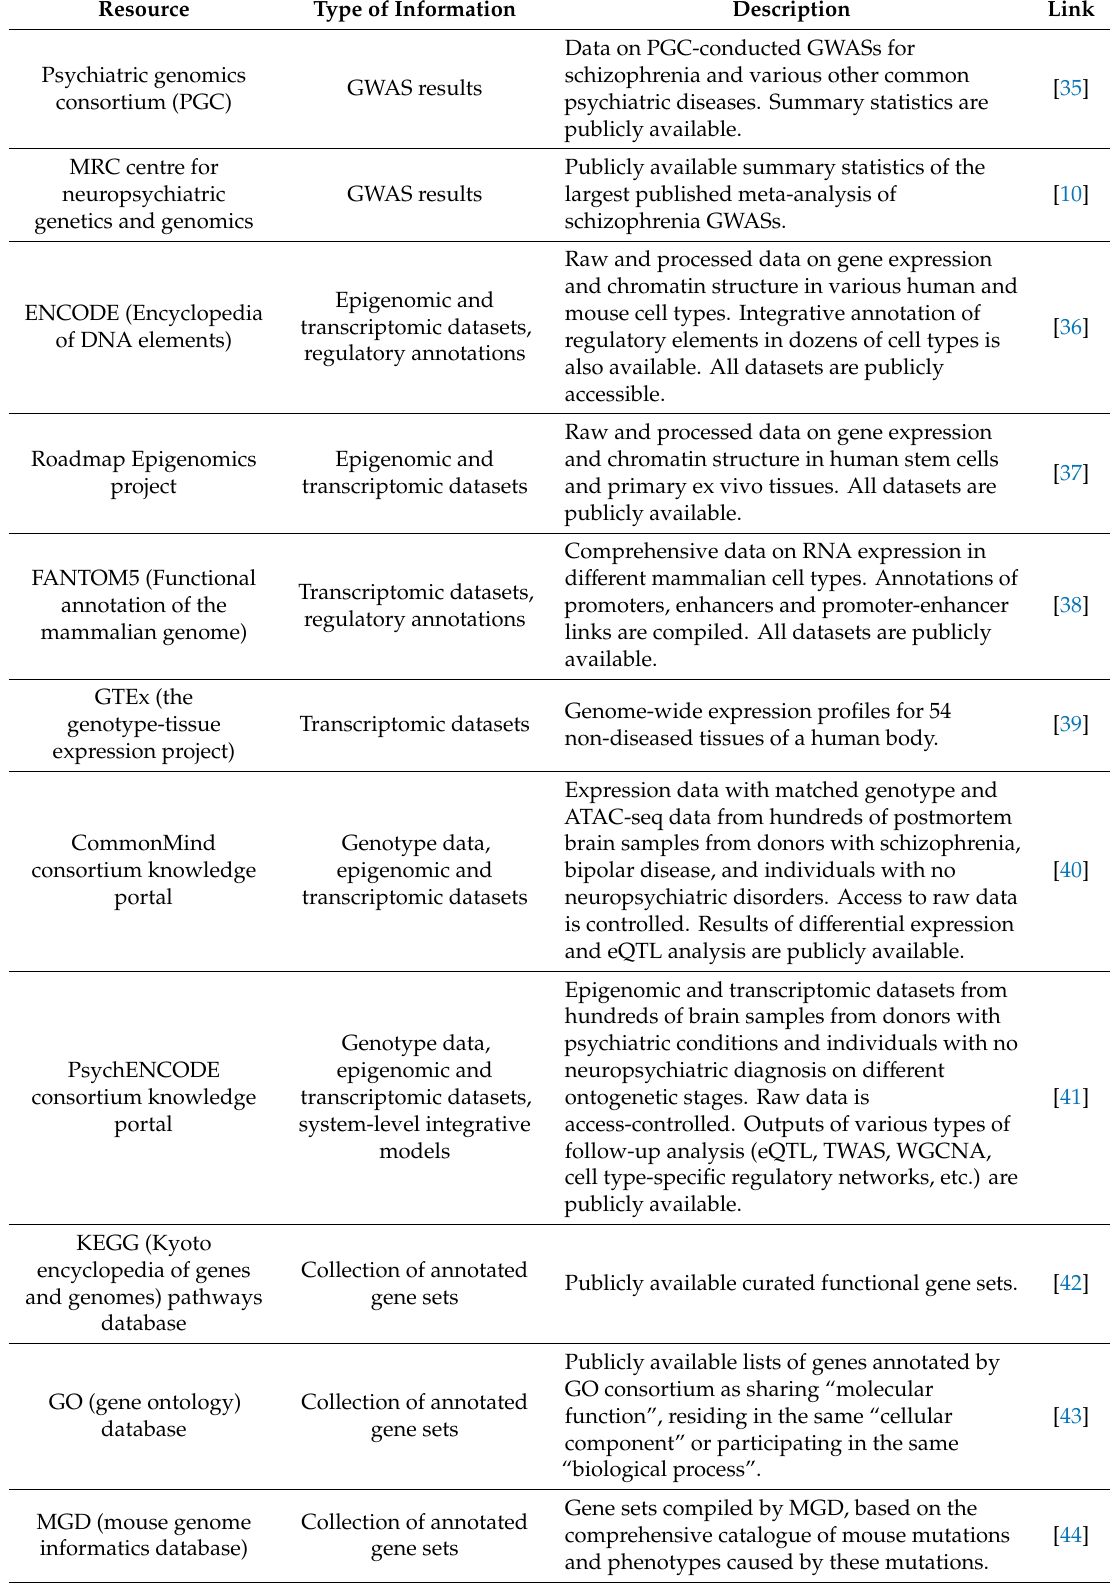
Table 2. Databases and other valuable datasets widely used in schizophrenia post-GWAS